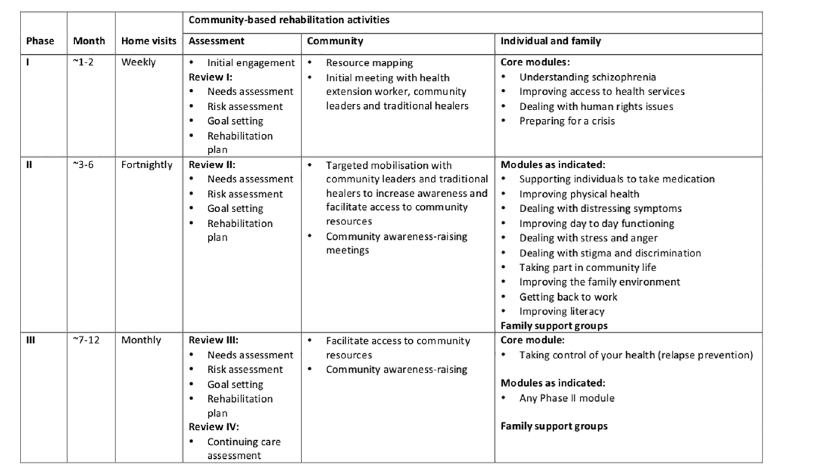
Fig 2. Overview of RISE intervention structure